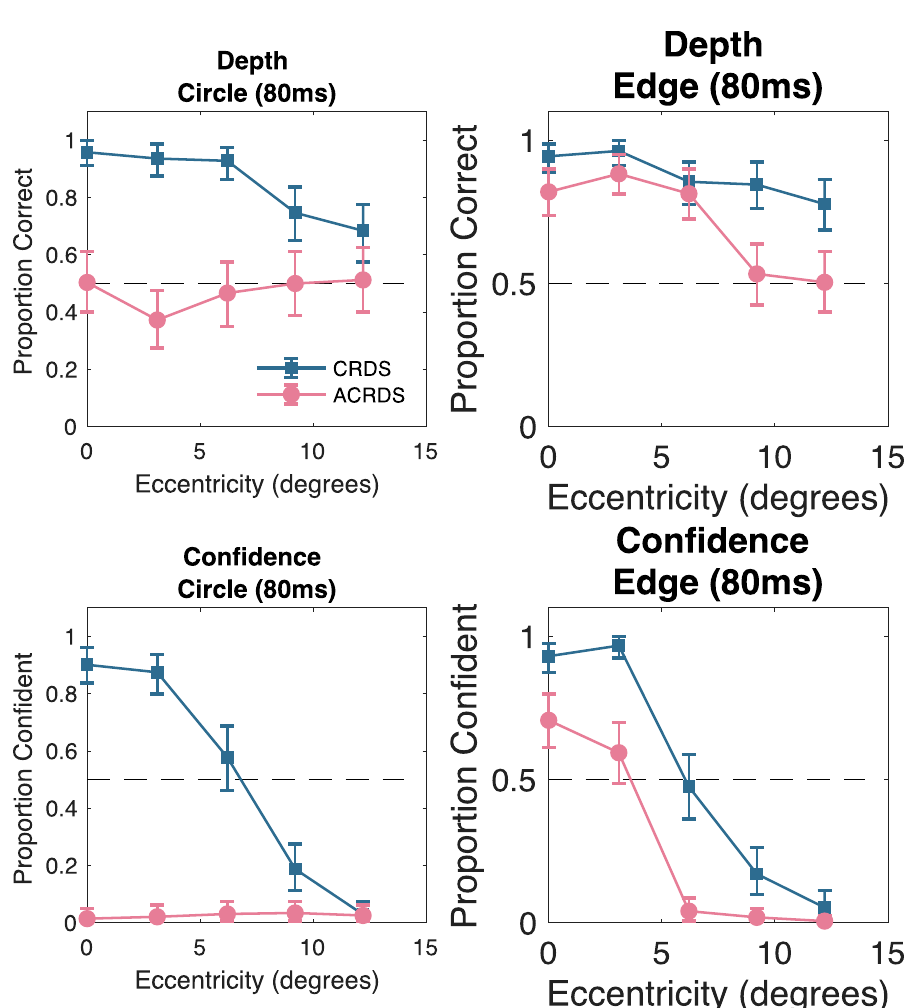
Fig 8. Accuracy and confidence of depth judgments for the short duration stimuli presented along the vertical meridian. The top row shows the accuracy judgments for the circular and edge stimuli, for each participant. The bottom row shows the confidence judgments. Error bars show 95 percent confidence